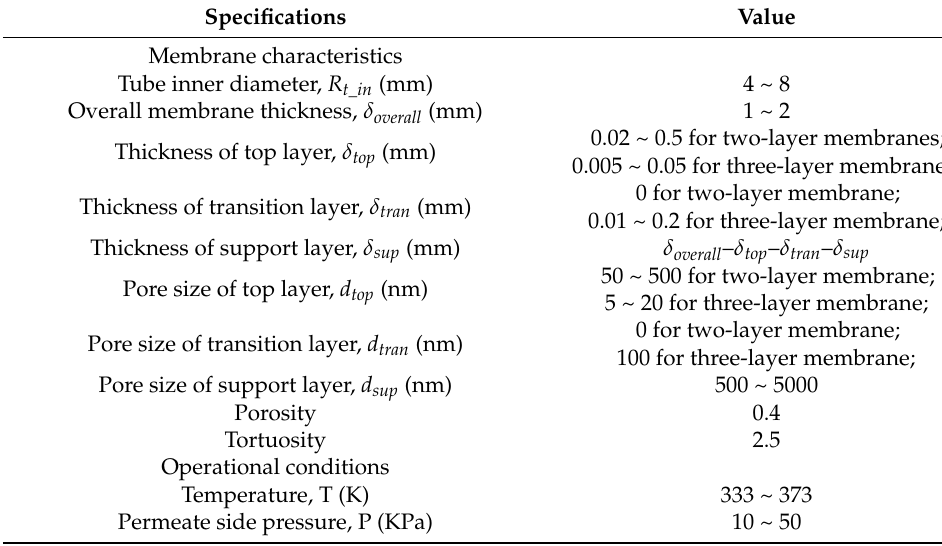
Table 1. Specifications of the membrane contactor and operational conditions. Specifications